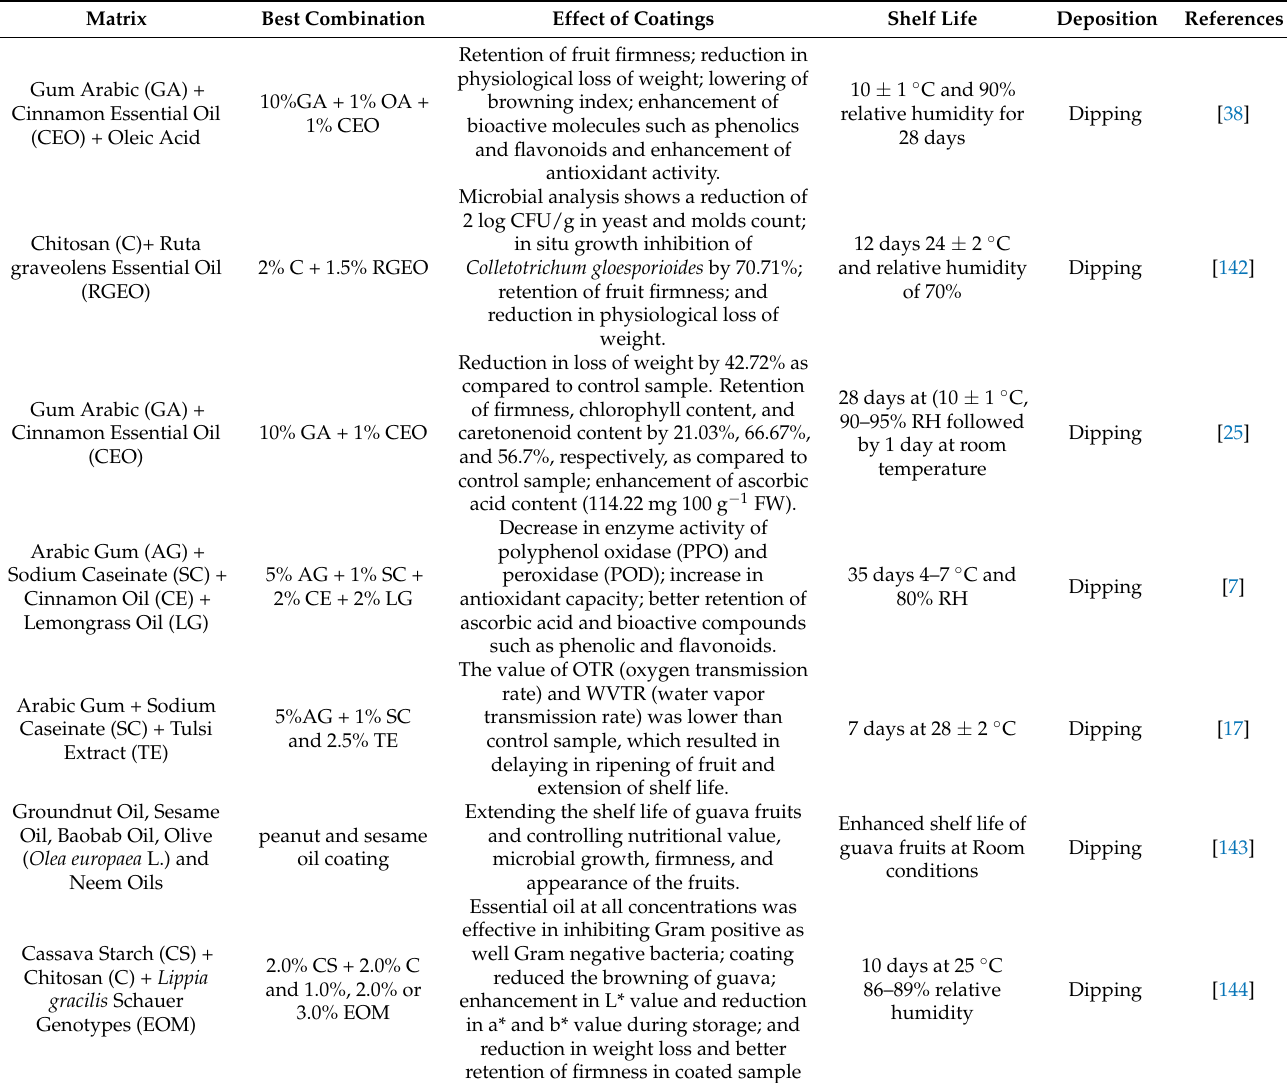
Table 3. Essential-oil-based edible coatings for enhancing the shelf life of guava